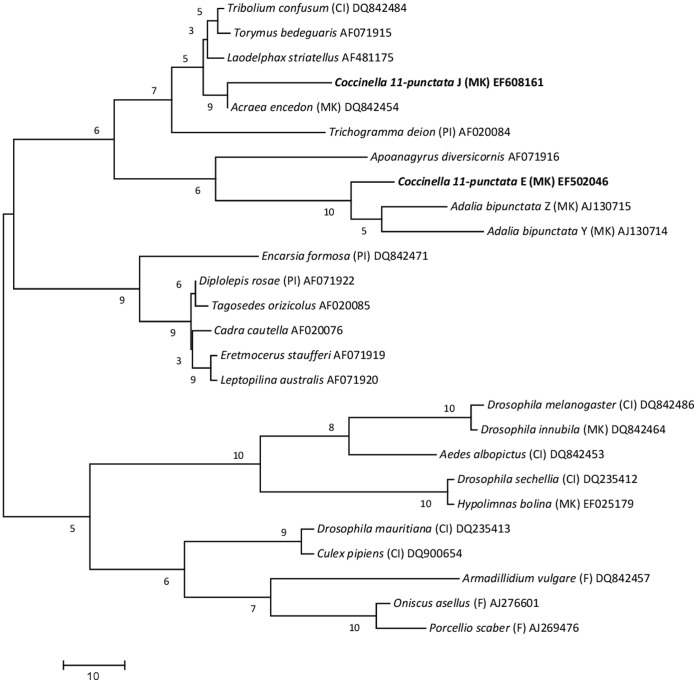
Phylogenetic tree of wsp DNA sequence data of Wolbachia hosted by different species.Maximum parsimony-based bootstrap analysis of different hosts of Wolbachia including the two Wolbachia strains of the C. undecimpunctata. Bootstrap values are indicated above the branches. Wolbachia strains are represented by the names of their host species, their phenotype where known (CI = cytoplasmic incompatibility; PI = parthenogenesis inducing; F = feminizing; MK = male-killing) and Genebank accession numbers. Suffix letters for A. bipunctata refer to the two different Wolbachia sequences, lodged by Hurst et al. (1999b). The wsp sequences found in this study are the Coccinella 11-punctata E (MK) EF502046 and Coccinella 11-punctata J (MK) EF608161 (in bold). Wolbachia wsp sequences used in constructing this tree were obtained from the Entrez Nucleotide database.